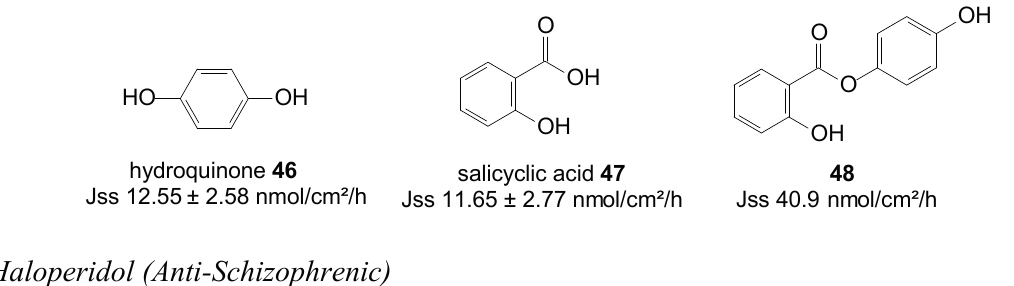
Figure 13. Structures of hydroquinone, salicylic acid and their best skin permeant ester co-drug 48 .